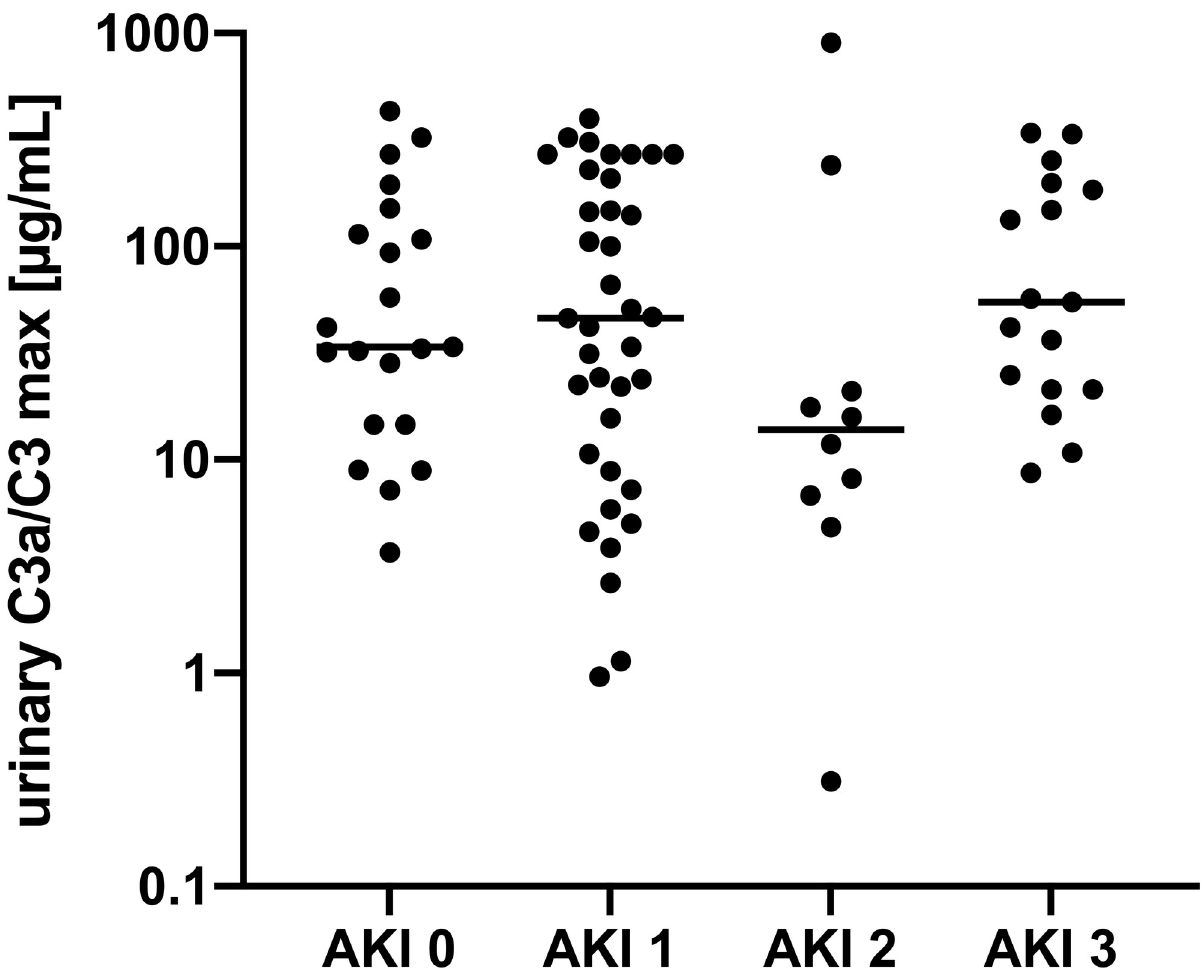
Fig 3. Peak urinary C3a/C3 level in patients categorized for stage of AKI. Peak levels of urinary C3a/C3 did not correlate with AKI stage. AKI 0 (n = 21), AKI 1 (n = 37), AKI 2 (n = 10) AKI 3 (n = 17).